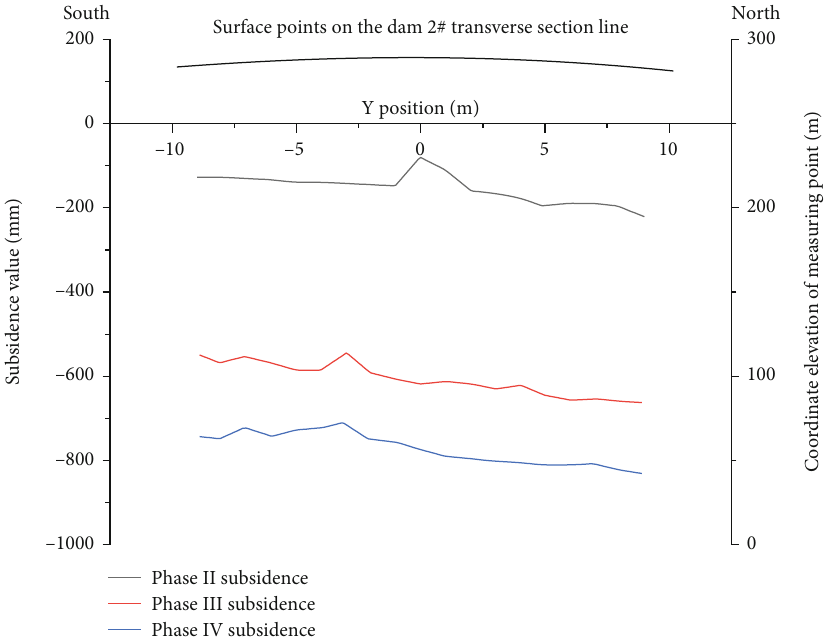
Figure 15: The subsidence with 1# lateral line in the dam.